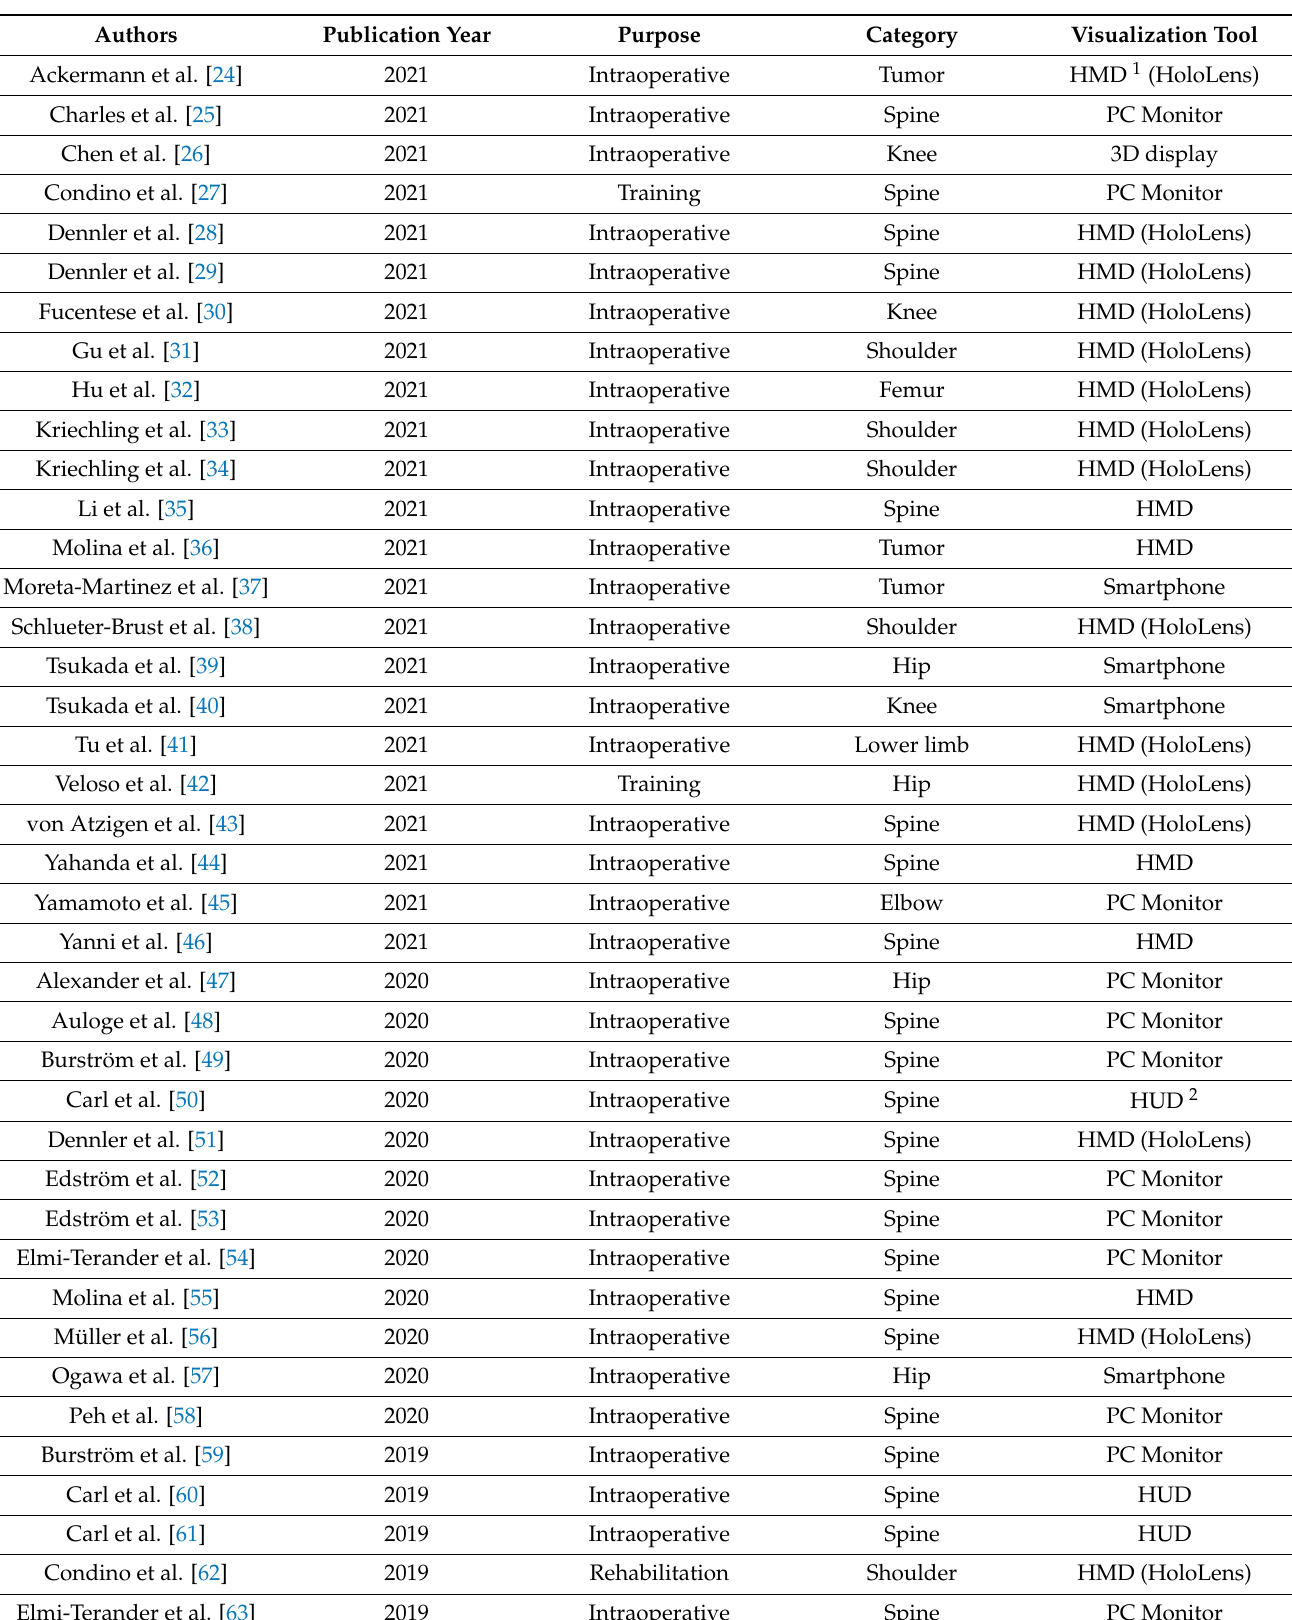
Table 1. Analyzed studies presenting AR applications in orthopedic